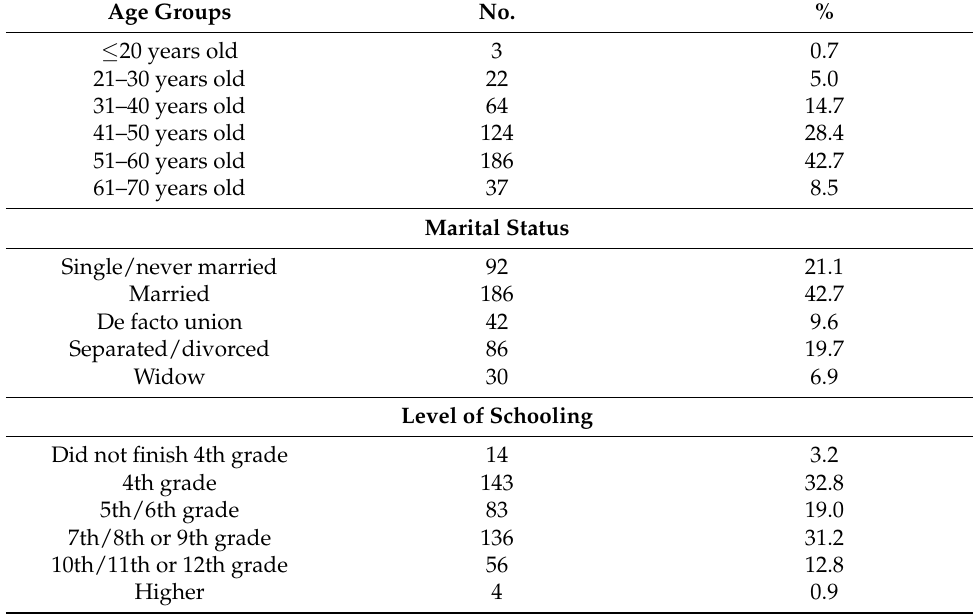
Table 2. Sociodemographic characterisation.